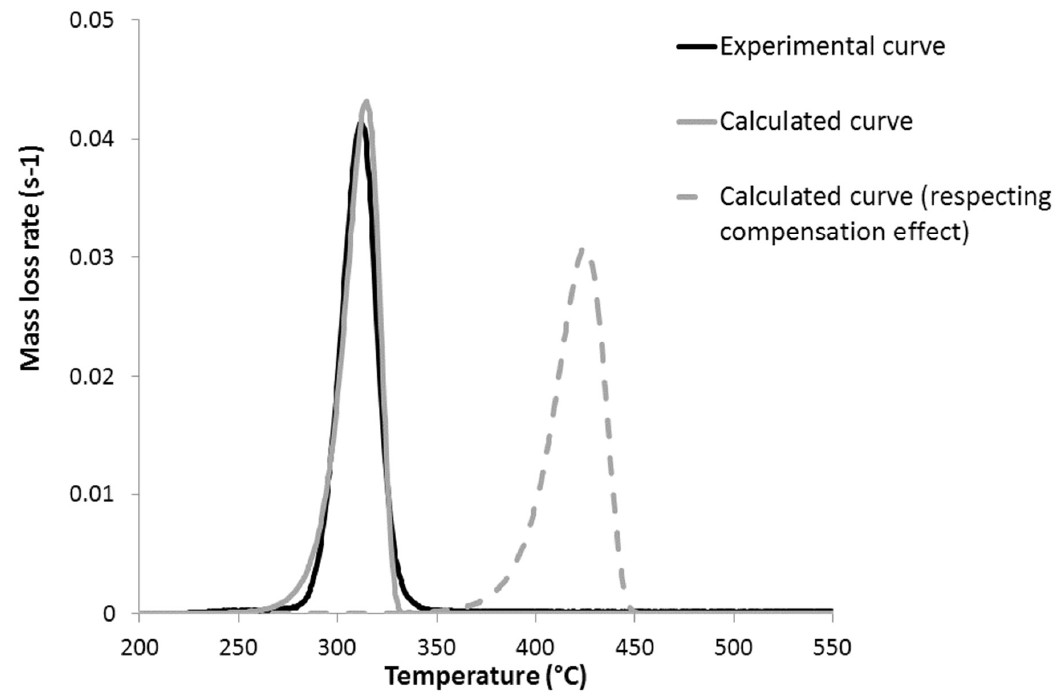
Figure 11 – Experimental and calculated mass loss rate curves at 1 K/s for PHB (PCFC). Calculation Figure 11. Experimental and calculated mass loss rate curves at 1 K/s for PHB (in a PCFC). Calculation was done with and without respecting the compensation was done with and without respecting compensation effect.